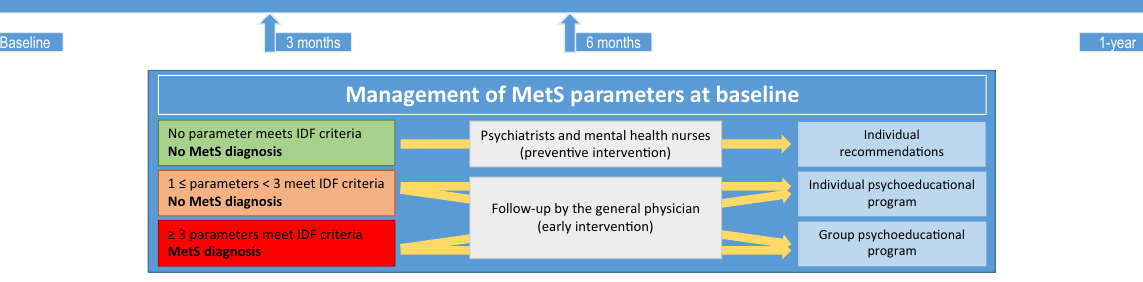
Figure 1. Characteristics and interventions of the early intervention program (EIP) in relation to metabolic syndrome (MetS) in the first year of follow-up of patients with recent-onset psychosis